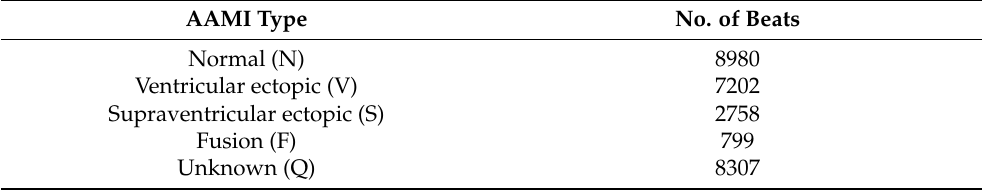
Table 17. Summary of the AAMI arrhythmia types extracted from the MITDB database.